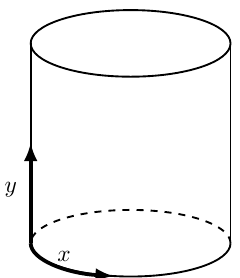
Figure 3. The Euclidean space-time cylinder representing the finite-size geometry in our anal- ysis. The coordinate x is compactified on a circle of circumference R , while the length L of the cylinder is assumed to be asymptotically large. In the picture where y is regarded as the Euclidean “time” the partition function (2.7) is dominated by the finite-size ground state contribution. In the complementary picture, where y is interpreted as spatial coordinate while x plays the role of the Matsubara “time”, the same partition function is given by the thermal trace